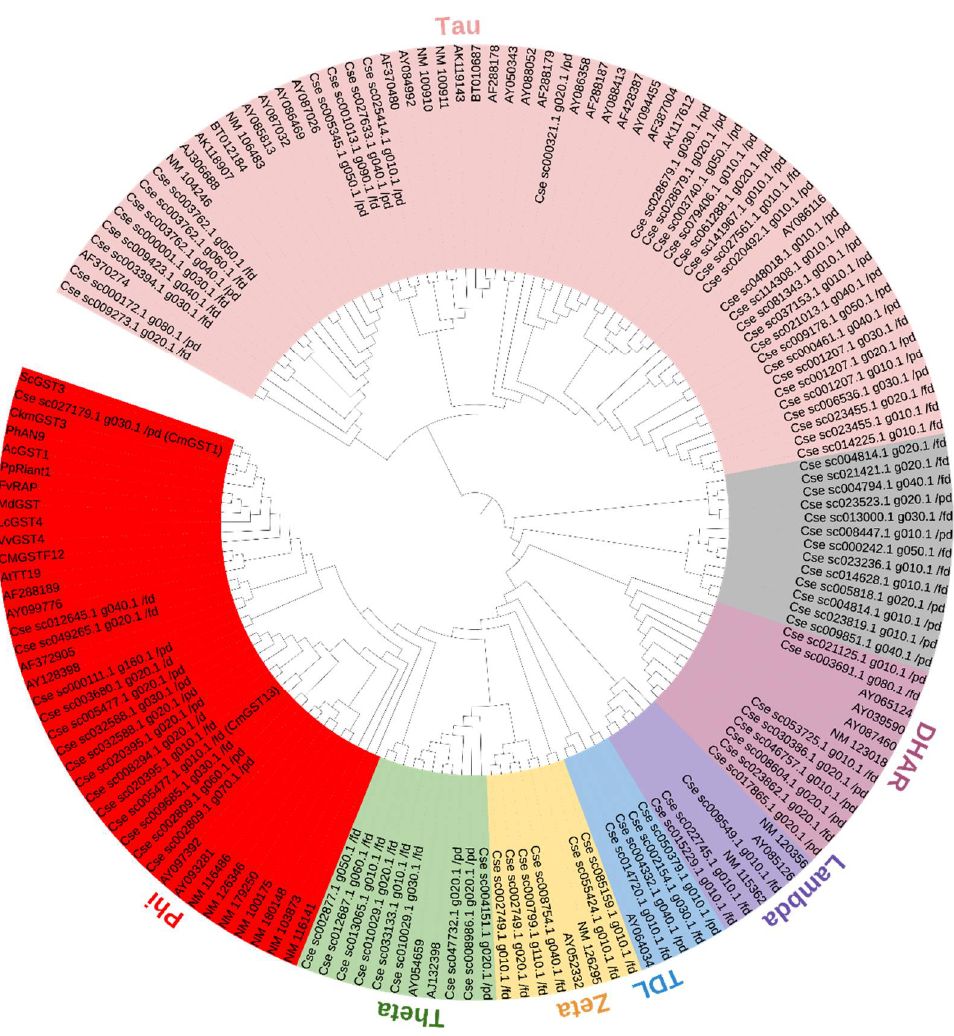
Figure 1. Phylogenetic analysis of 94 CmGSTs with GSTs from Arabidopsis and reported anthocyanin-related GSTs in other species. The 94 CmGSTs proteins were obtained from the Chrysanthemum genome (http://mum-garden.kazusa.or.jp Accessed on 6 August 2021). The GenBank accession numbers were: PpRiant1 (ALE31199), MdGST (NP_001315851.1), FvRAP (XP_004288578), LcGST4 (ALY05893), VvGST4 (AAX81329), CMGSTF12 (ABA42223), ScGST3 ( Senecio cruentus ), AtTT19 (BAD89984), AcGST (QCQ77644), PhAN9 (CAA68993), CkmGST3 (BAM14584), The tree was constructed with the Maximum Likelihood method (1,000 replications of bootstrap test) using the Iqtree